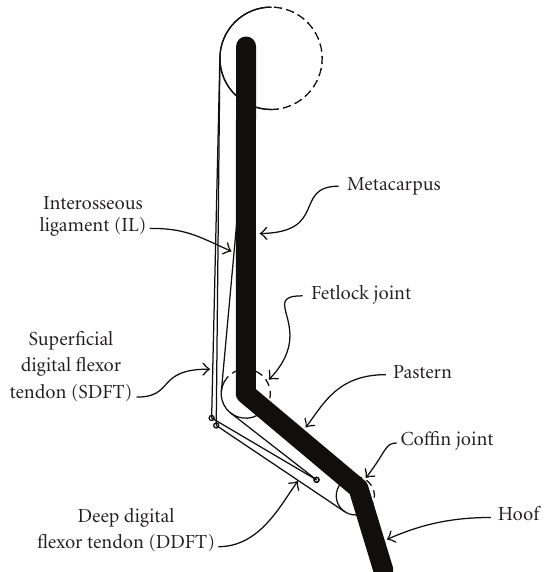
Figure 1: Two-dimensional, sagittal plane model of the equine forelimb. The model contained three rigid body segments and three major tendinous structures.